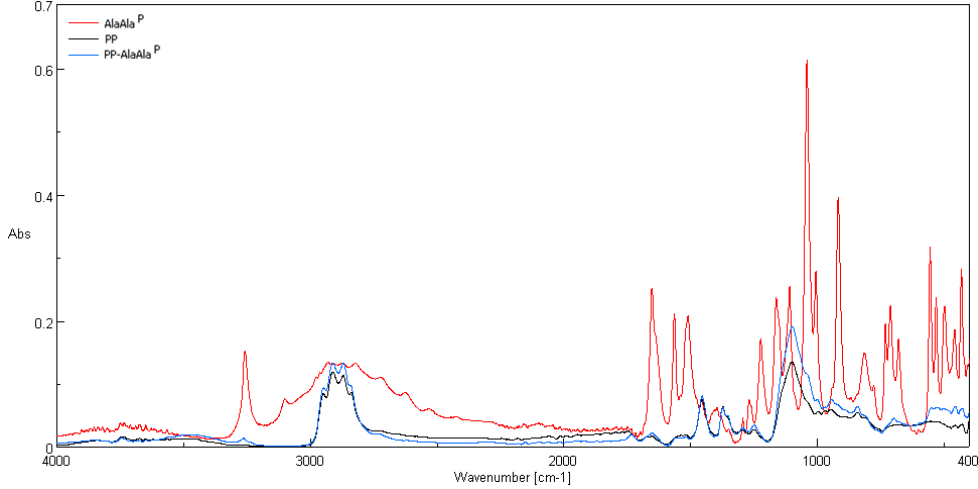
Figure 3. ATR-FTIR spectra of Ala-Ala P , polypropylene nonwoven (PP), and nonwoven sample charged with Ala-Ala P (0.15%) (PP/Ala-AlaP). Table 5. Characteristic FTIR bands determined for Ala-Ala P , polypropylene (PP), and Ala-Ala P -polypropylene nonwoven hybrid (PP/Ala-Ala P ).